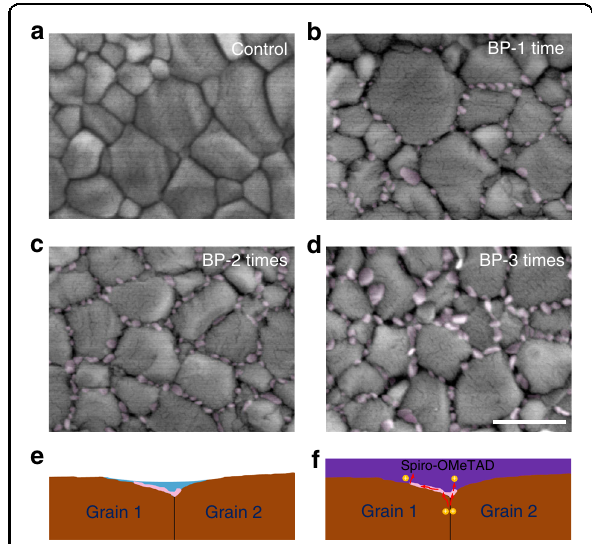
Fig. 2 Morphology of the BP-modi fi ed MAPbI 3 perovskite fi lms. a – d SEM images of the perovskite fi lms without and with 1 – 3 coats of BP fl akes. The scale bar is 500 nm. e Schematic diagram of the grain boundary (GB) area when the BP dispersion in IPA was spin coated on the perovskite fi lms. f Schematic diagram of the GB area after the deposition of BP and spiro-OMeTAD. Holes can transfer from the GB to the BP fl ake and then transport along the fl ake to the hole transport material